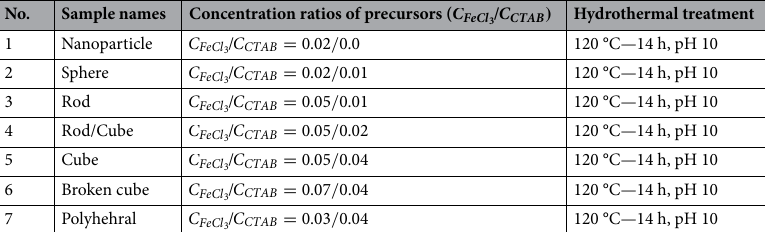
Table 2. Preparation conditions and samples synthesized via hydrothermal